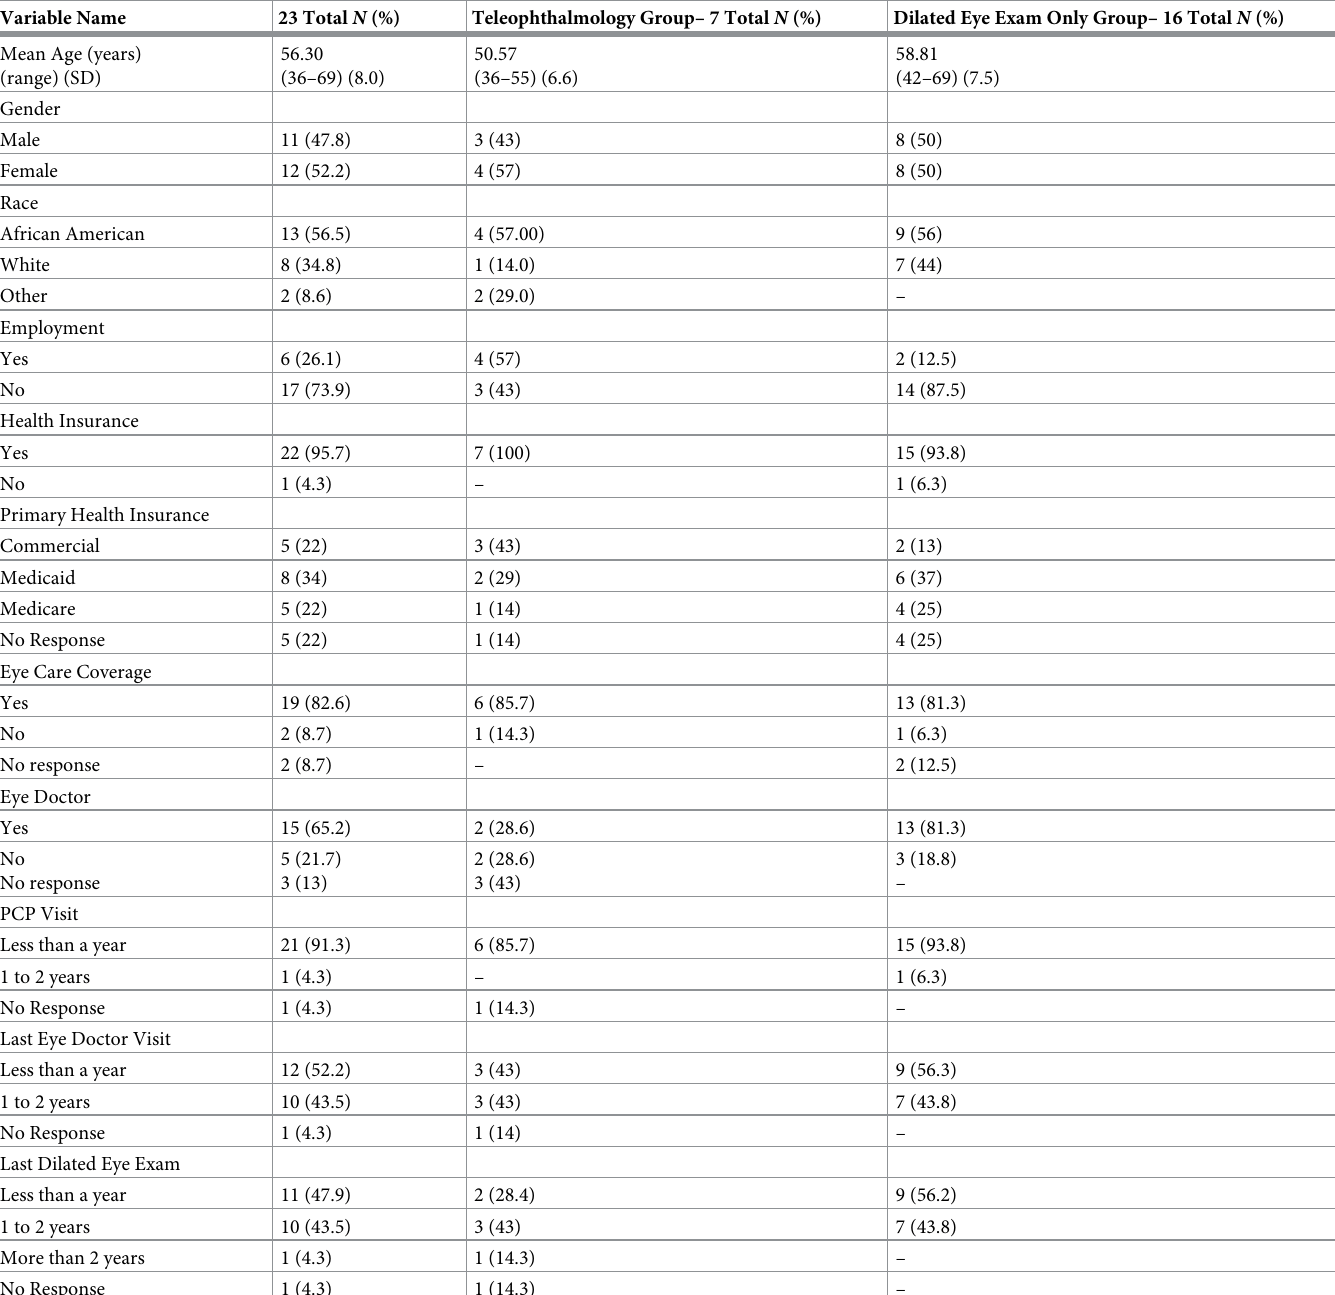
Table 1. Participant characteristics (N = 23)